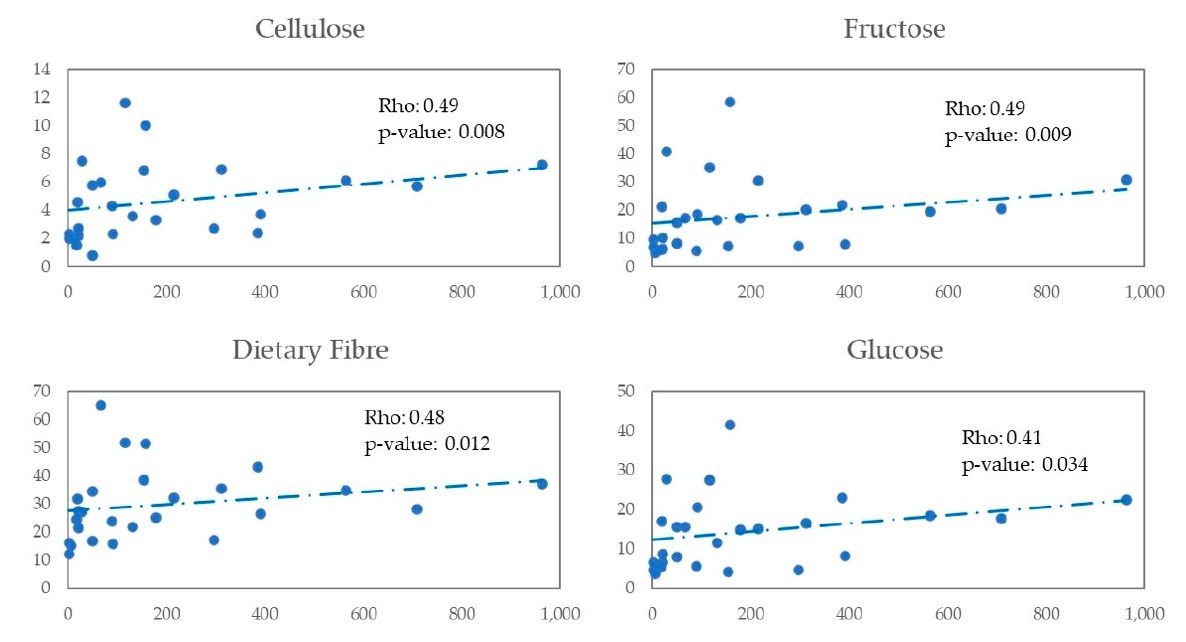
Figure 4. Scatter plot X— Lachnospira , Y—Nutrients/Food.